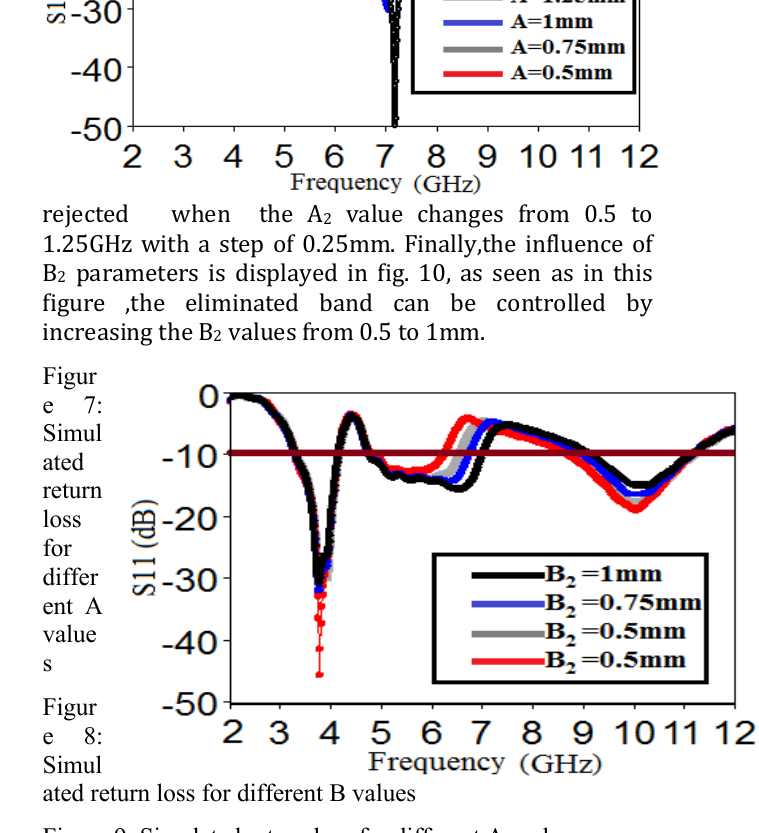
Figure 9: Simulated return loss for different A 2 values Figure 10: Simulated return loss for different B 2